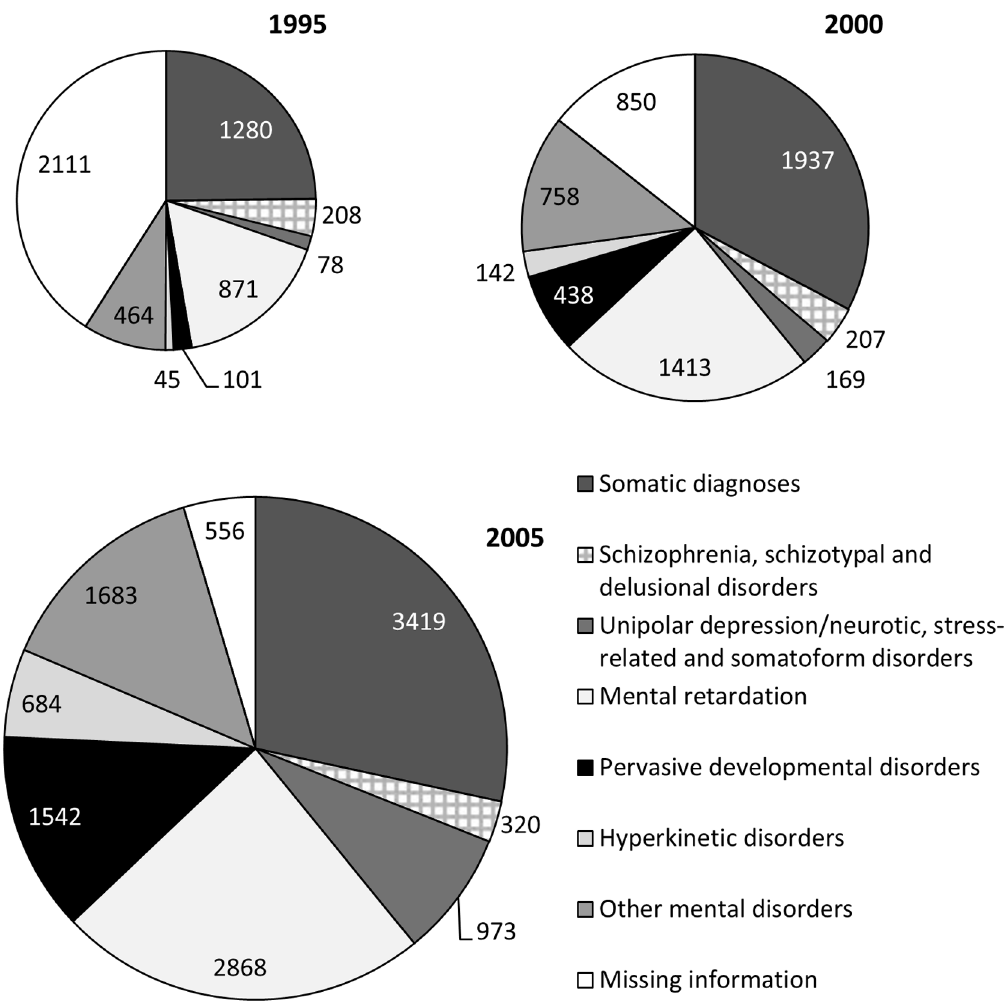
Figure 2. The diagnoses for which disability pension was granted within each cohort. The number of young adults aged 19–23 years on disability pension in the years 1995, 2000 and 2005, divided into diagnostic groups. The relative size of the diagrams represents the proportion of young adults in the specific age group granted disability pension.